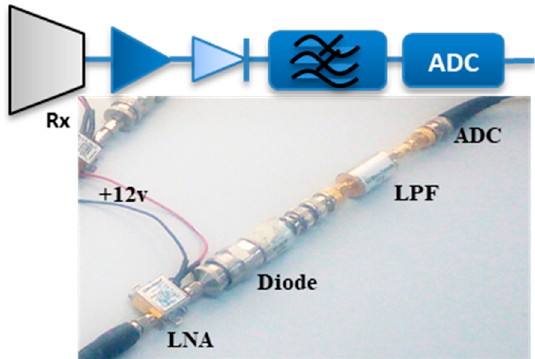
Figure 6. A simple FSR (Forward Scattering Radar) receiver circuit for drone detection. LNA - Low Noise